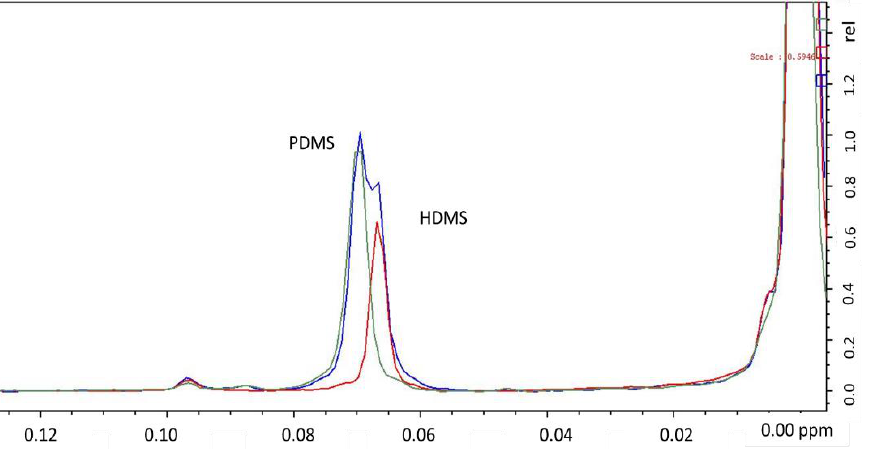
Figure 2. 1 H-NMR spectra of PDMS and HMDS dissolved in deuterated chloroform (CDCl 3 ; 500 MHz Bruker NMR) with TMS reference at 0 ppm. Green (PDMS) and red (HDMS) lines show deconvolved compound signals.